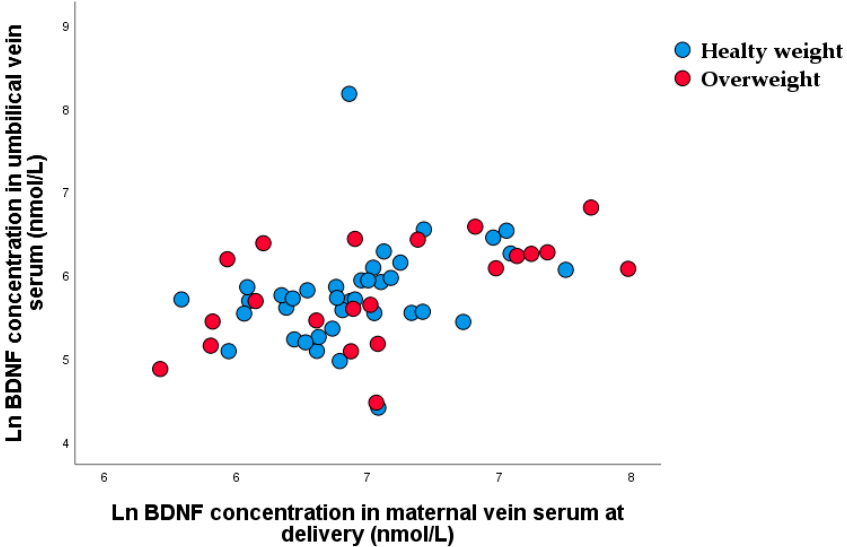
Figure 7. Scatter plot of nonparametric correlations between maternal and umbilical vein serum BDNF at the time of delivery (r rho = 0.494, p < 0.001).